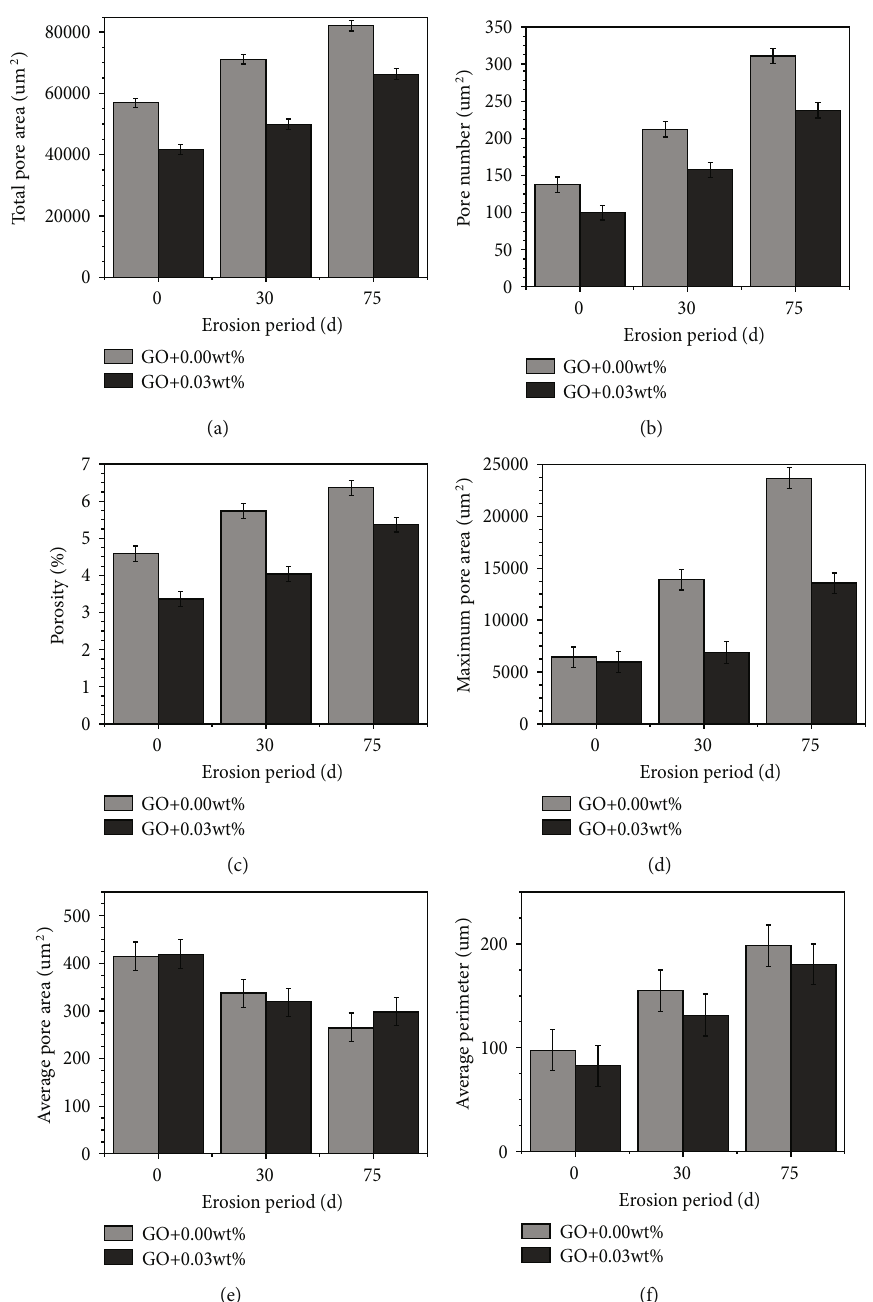
Figure 9: Pore parameters: (a) total pore area, (b) pore number, (c) porosity, (d) maximum pore area, (e) average pore area, and (f) average